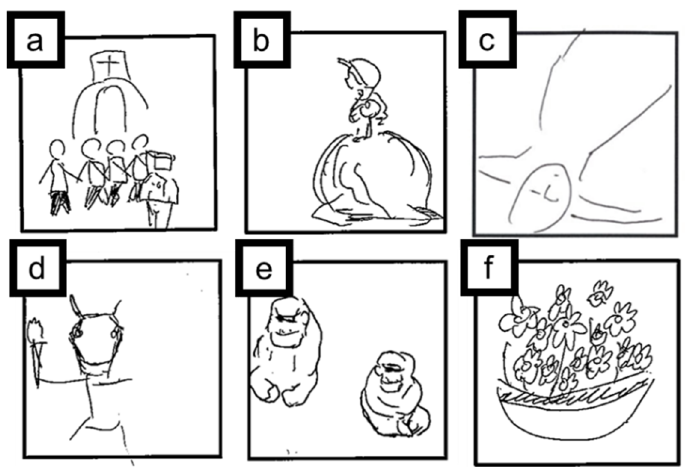
Figure 4. Examples of the drawings by the participants of the shapes that they saw in the random dots (( a ) soldiers walking in front of a church, ( b ) a noblewoman, ( c ) a person who has fallen down, ( d ) a minotaur, ( e ) two monkeys, and ( f ) a vase).